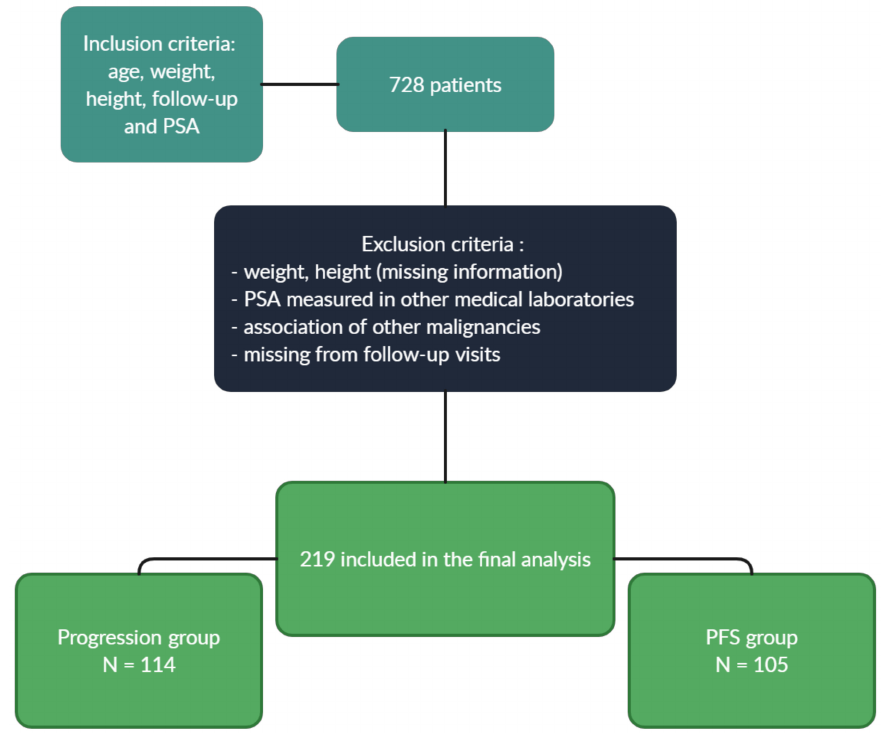
Figure 1. Inclusion and exclusion